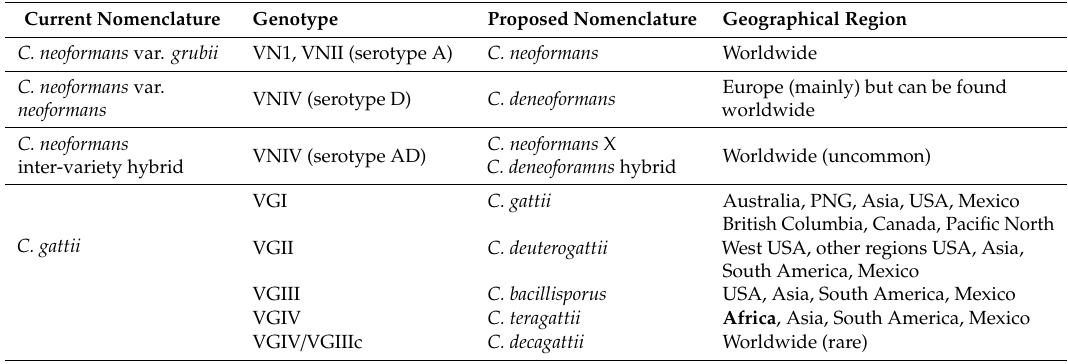
Table 1. Proposed taxonomical changes for the Cryptococcus neoformans and Cryptococcus gattii species complex: nomenclature, genotype and geographic distribution of